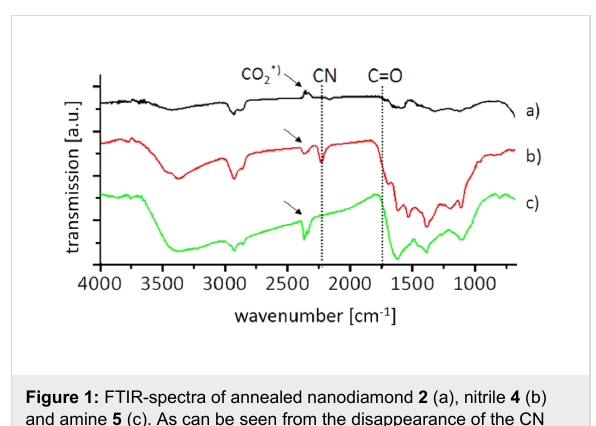
Figure 1: FTIR-spectra of annealed nanodiamond 2 (a), nitrile 4 (b) and amine 5 (c). As can be seen from the disappearance of the CN signal after the reduction of 4 the nitrile is fully converted into the aminomethyl group. The C=O signal position is given as reference to show the absence of respective groups. The peaks marked with an arrow (CO 2 *) at 2200–2300 cm − 1 are due to carbon dioxide from ambient